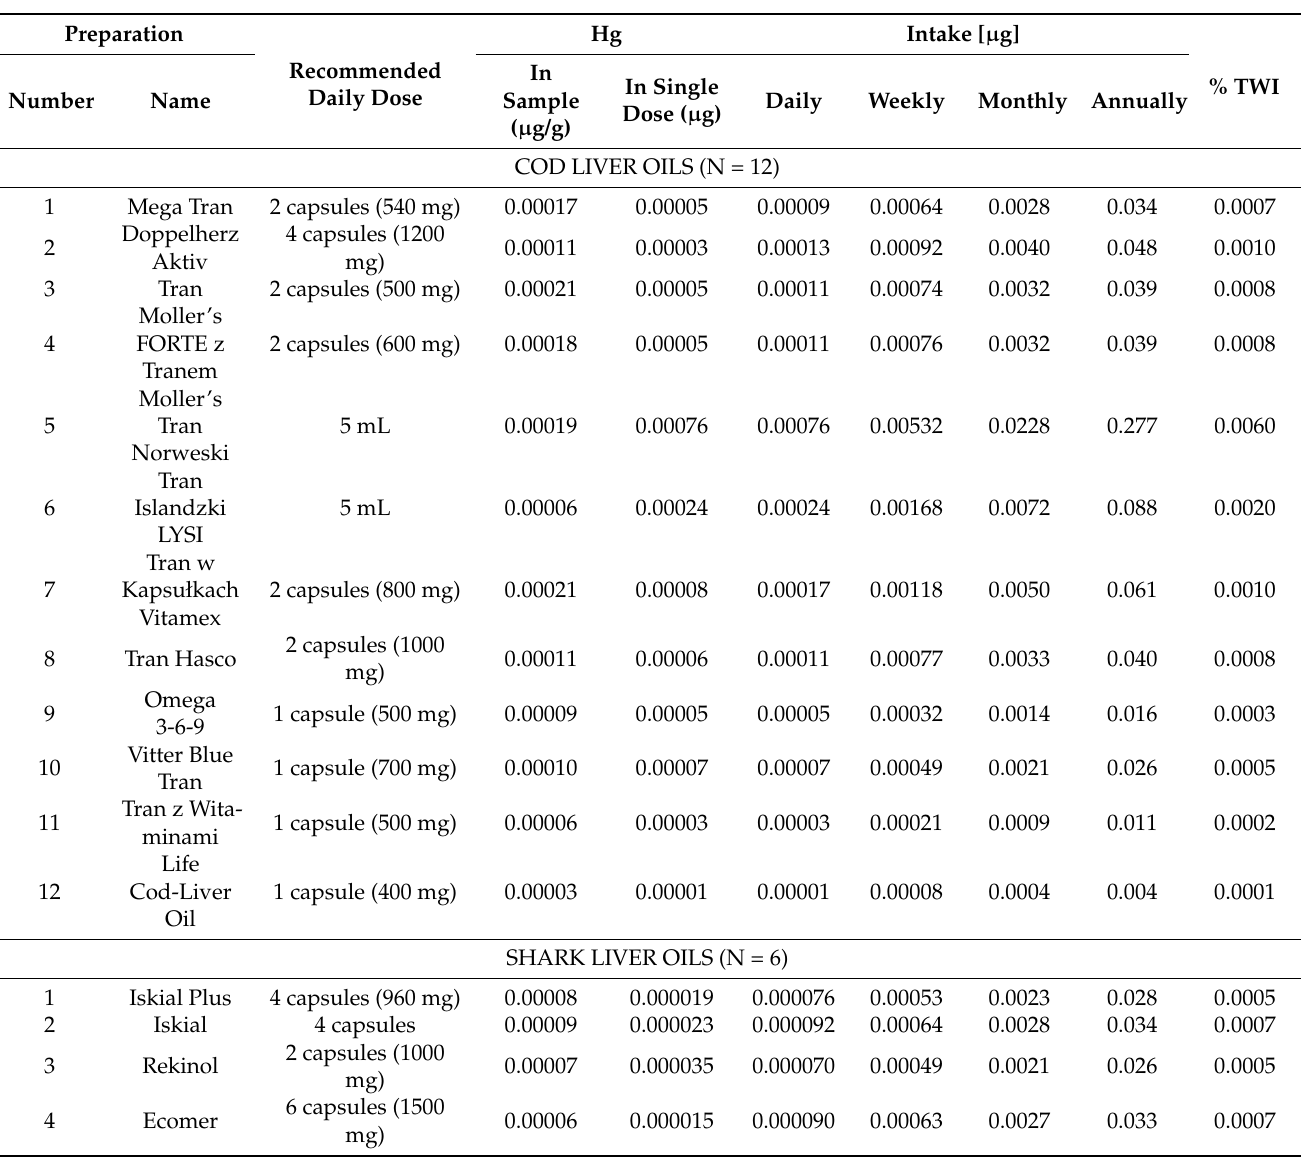
Table 3. Mercury supply from dietary supplements in the case of daily, weekly, monthly, and annual